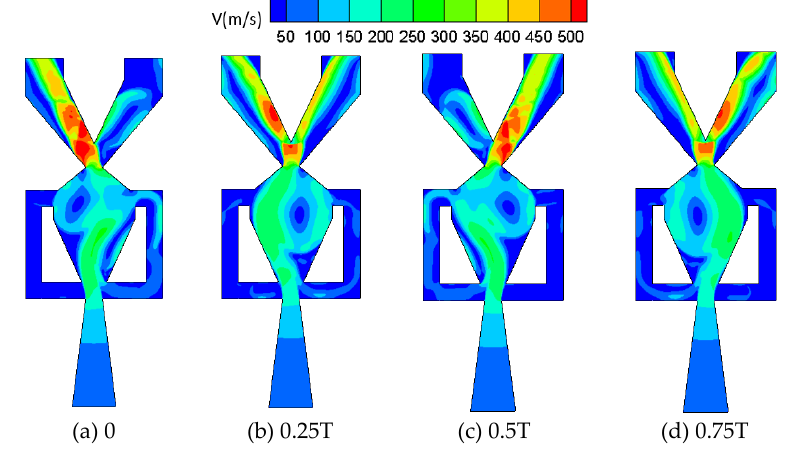
Figure 15. Velocity distributions at different times.